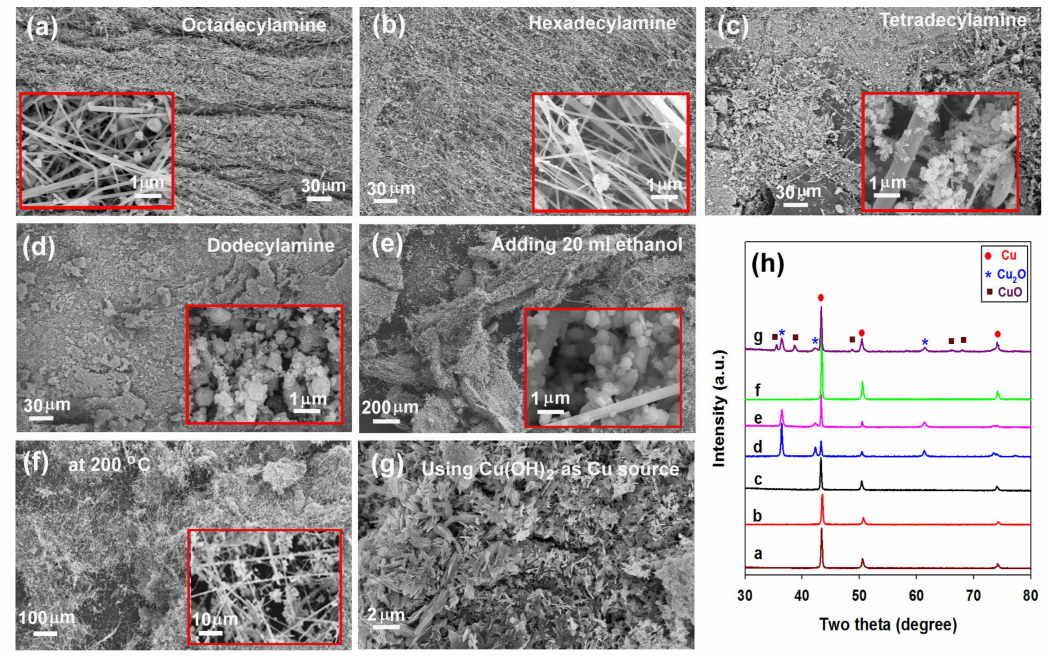
Figure 1. ( a – d ) Scanning electron microscope (SEM) images of the products formed at 160 ◦ C for 96 h by replacing oleylamine with octadecylamine, hexadecylamine, tetradecylamine, or dodecylamine; ( e – g ) SEM images of the products formed in the presence of oleylamine for 96 h by adding 20 ml ethanol as reducing agent, changing reaction temperature from 160 ◦ C to 200 ◦ C, or replacing CuCl 2 with Cu(OH) 2 as Cu source; ( h ) X-ray diffraction (XRD) patterns of the products presented in Figure 1a–g. Insets of Figure 1a–f are high-magnification SEM images of the corresponding products.